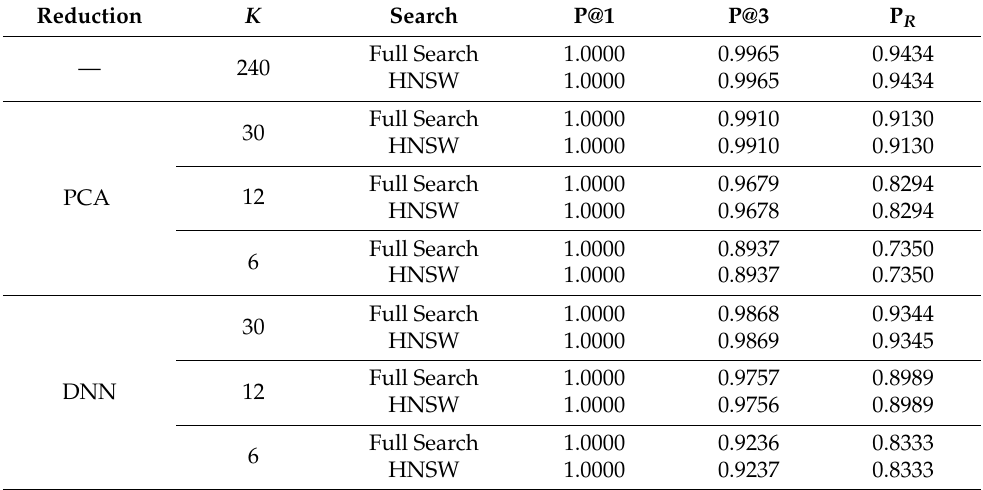
Table 3. Retrieval quality for various reduction approaches and search strategies using the dataset D sm . Note that the evaluation measures for the KD search approach are identical to the full search